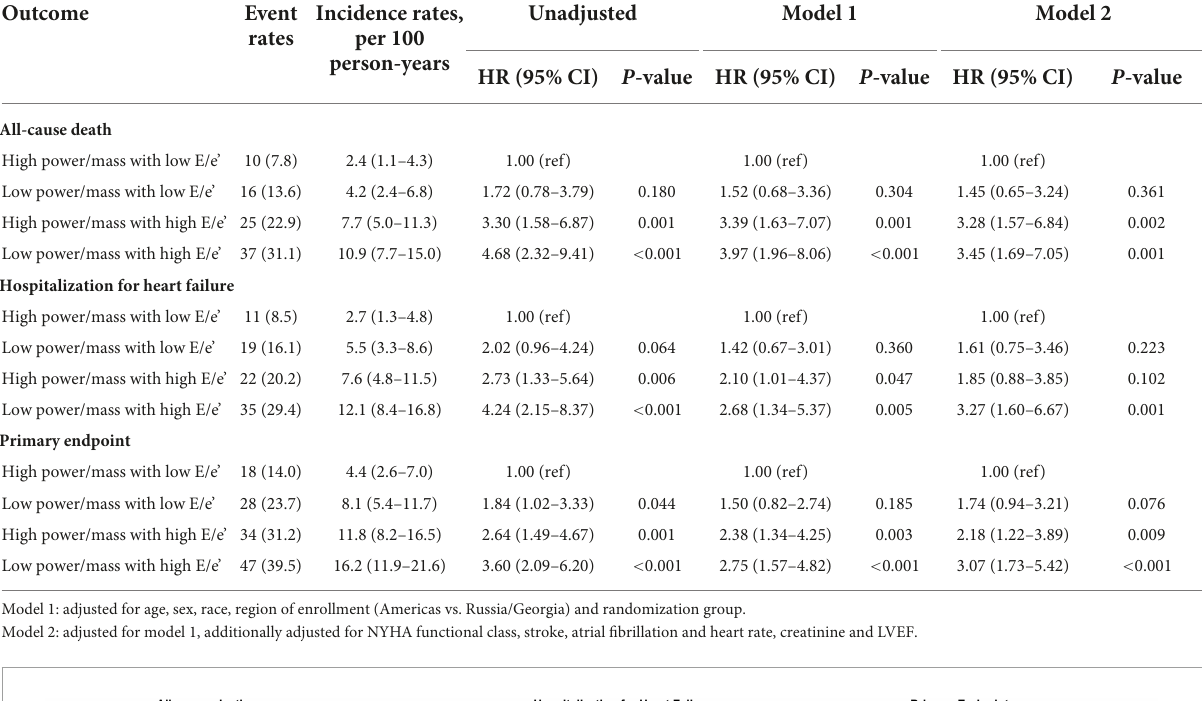
TABLE 2 Risk of all-cause death, hospitalization for heart failure and primary endpoint in HFpEF patients by power/mass and E/e’ ratio categories. Outcome Event Incidence rates, Unadjusted Model 1 rates per 100 person-years